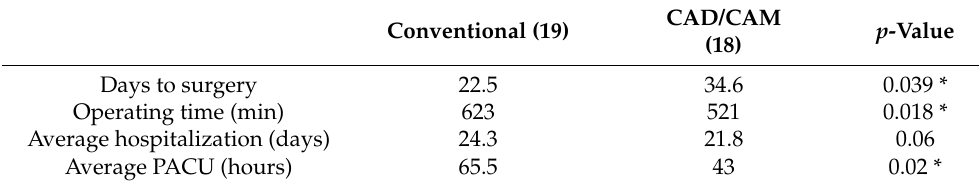
Table 2. Continuous data